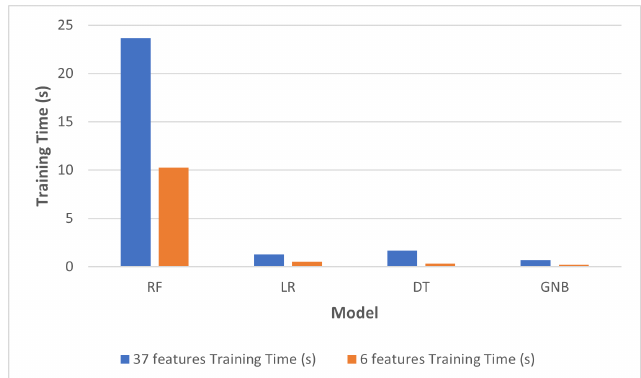
Figure 7. Change in training time after feature reduction.